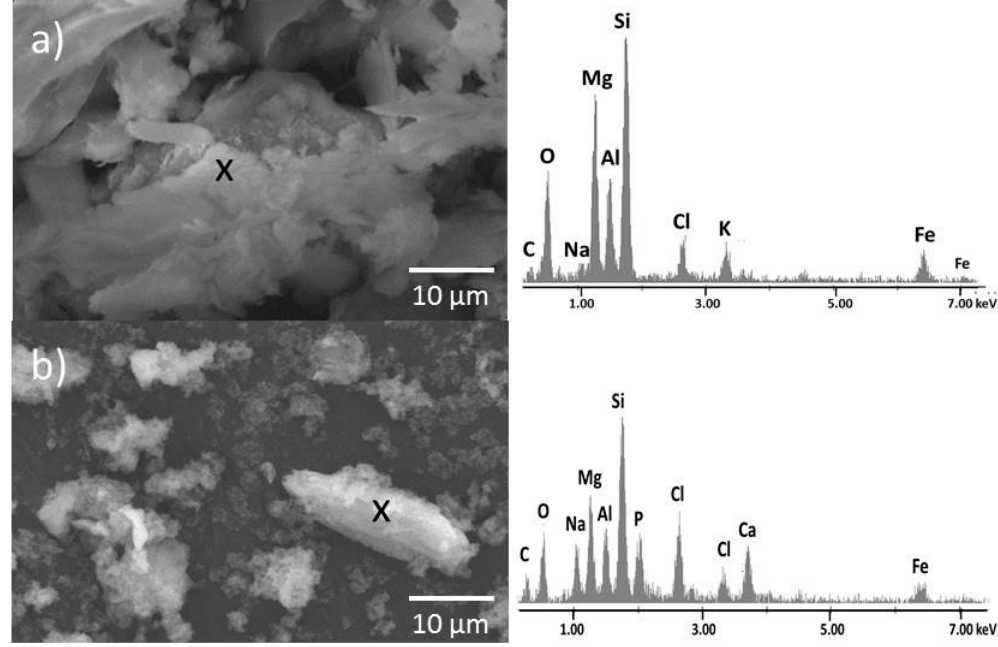
Figure 7. SEM image of ( a ) VCA and ( b ) VCAH with adequate representative EDS analysis.